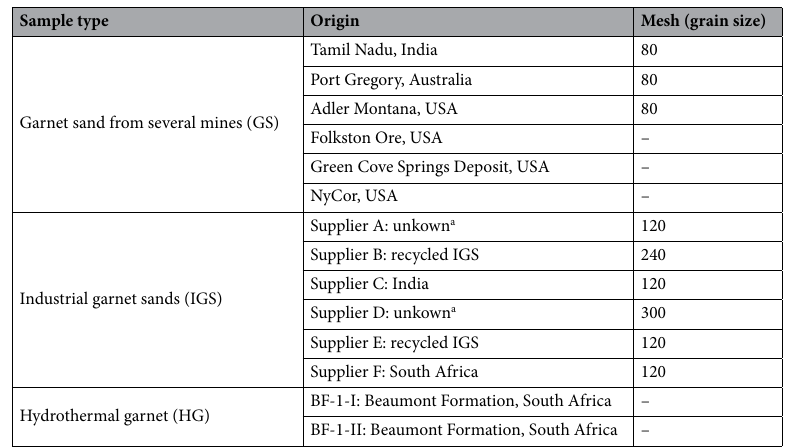
Table 2. Detailed overview over origin of samples and mesh size when applicable. a The supplier did not provide information on the origin of the